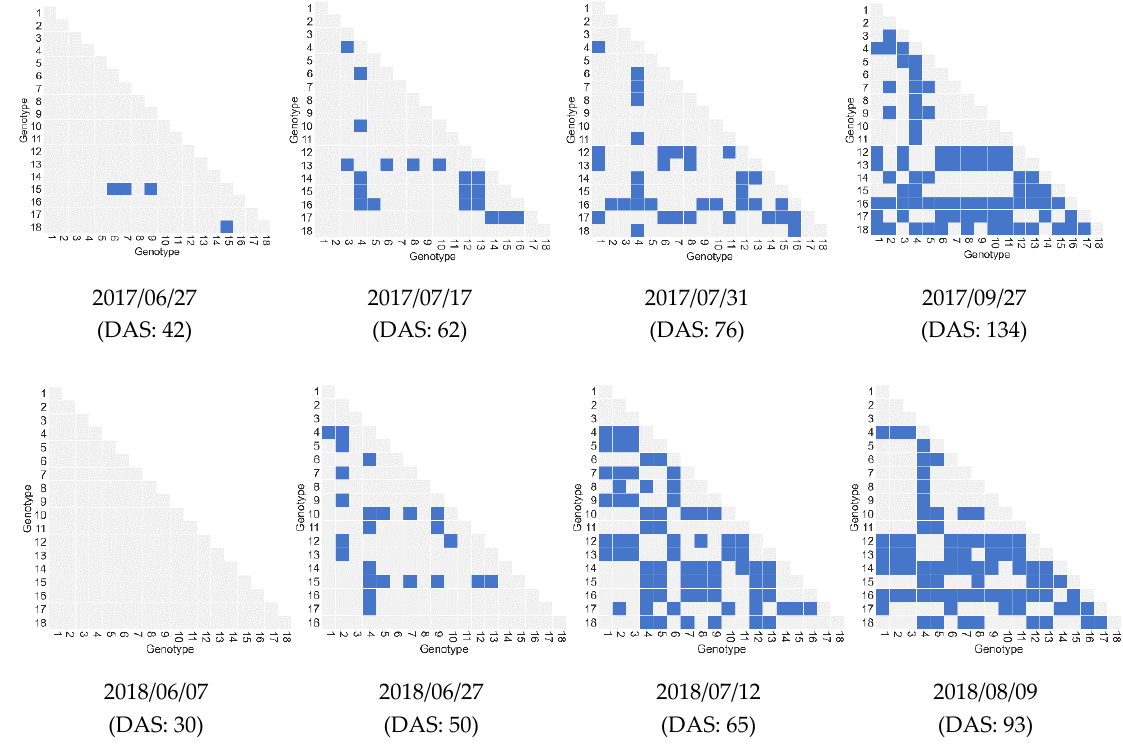
Figure 4. Tukey’s pairwise multi-comparison test for the fresh biomass data collected in the 2017 and 2018 growing seasons for the 18 genotypes planted in HyCal-17 and HyCal-18 experiments. Blue indicates that the two varieties are significantly different (α = 0.05).